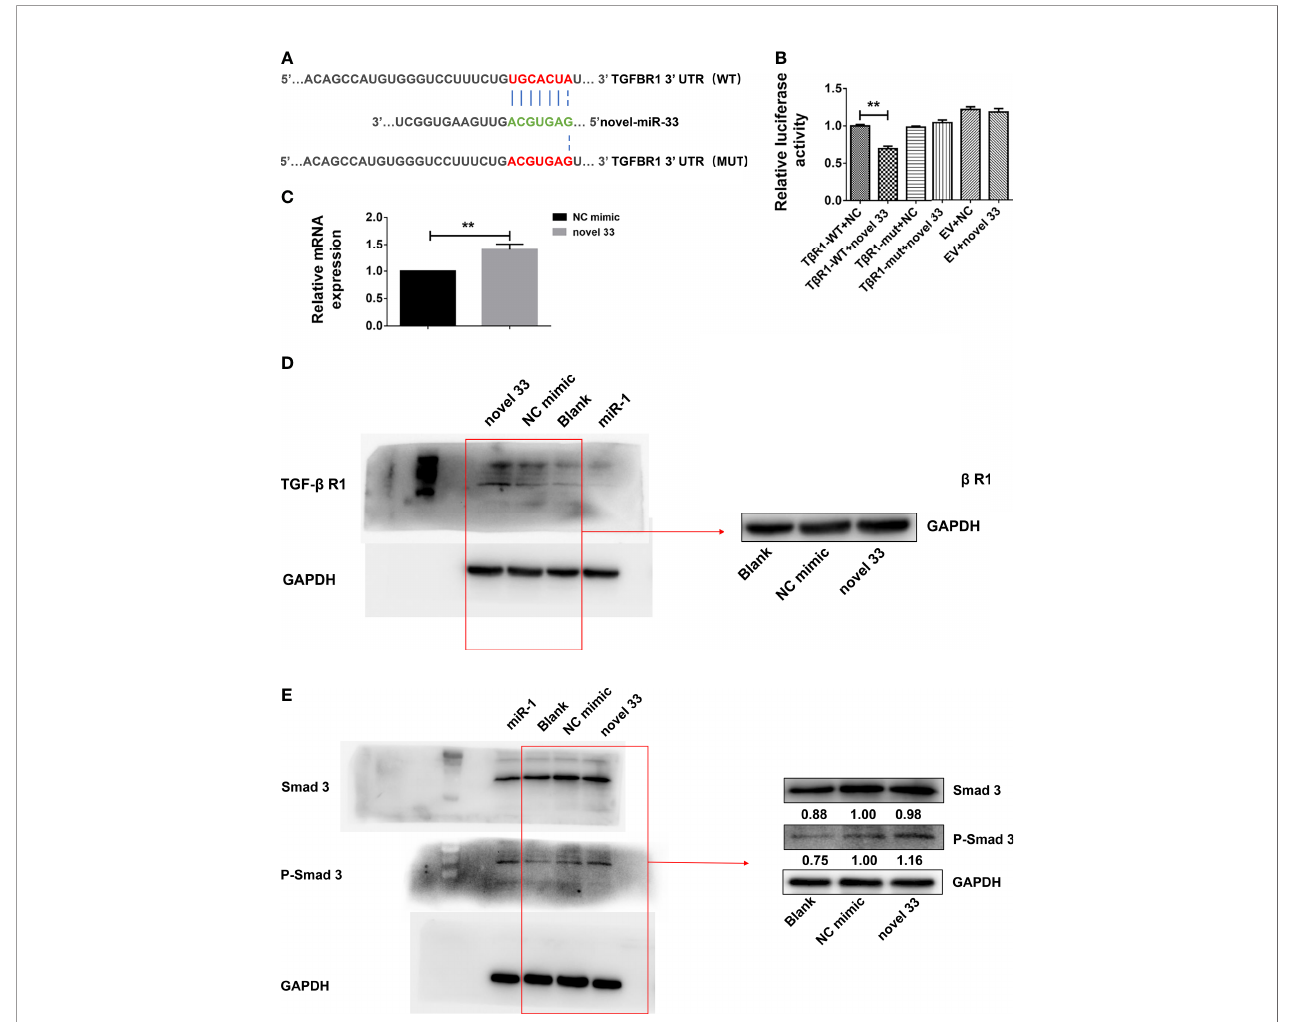
FIGURE 5 | Novel miRNA-33 acts via the TGF b /Smad pathway to promote liver fi brosis. LX-2 cells were transfected with the novel miRNA-33 mimic and NC mimic. Total RNA was extracted 24 h after transfection of LX-2 cells, and protein was extracted 48 h after transfection of LX-2 cells. The blank control group did not receive treatment. Only the gray values of the NC mimic group and the novel 33 group were statistically analyzed; the blank group was not analyzed. Results were compared with the NC mimic group; the blank group was only used as a reference without comparative analysis. (A) Sequence alignment of novel miRNA-33 and the target region in the 3 ’ UTR of TGF- b RI. (B) Luciferase reporter assays were performed on 293T cells transfected with pmirGLO-TGF- b RI 3 ’ UTR-WT or pmirGLO-TGF- b RI-3 ’ UTR-Mut in the absence or presence of novel miRNA-33 mimic. (C) qPCR results showing that novel miRNA-33 upregulates TGF- b RI expression. (D) Western blotting results showing that novel miRNA-33 upregulates TGF- b RI expression. (E) Smad3 is phosphorylated after transfection of LX-2 cells with novel miRNA-33. Expression levels of TGF- b RI, Smad3, and P-Smad3 were normalized against GAPDH. Results are averaged from three independent experiments, and Student ’ s t -tests were applied to assess differences between two groups ** p <